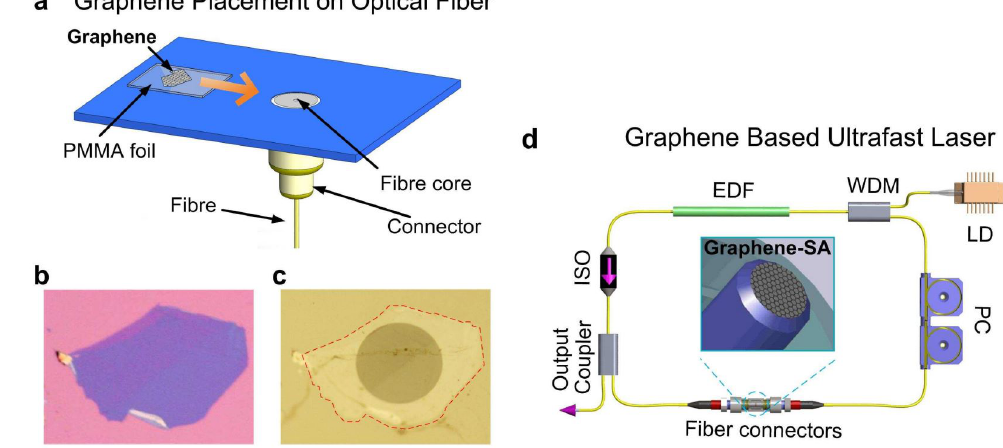
Figure 9. Integration of graphene in fiber laser. ( a ) an optical fiber is placed in a holder when the graphene is detached from the substrate, graphene is aligned with the fiber; ( b ) flake deposited on Si/SiO 2 ; ( c ) same flake after polymer dissolution; ( d ) ultra-fast mode-locked laser having graphene saturable absorber (SA), erbium-doped fiber (EDF), laser diode (LD), wavelength-division multiplexer (WDM), isolator (ISO) and polarization controller (PC). Reprinted with permission from [44]. Copyright (2010) Nature Publishing